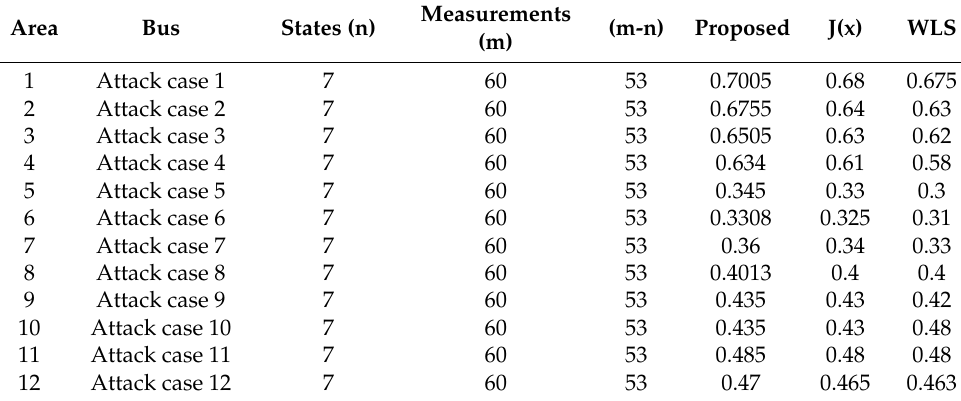
Table 2. Objective function for different Attack Table 1. Compromised Bus numbers with Error.